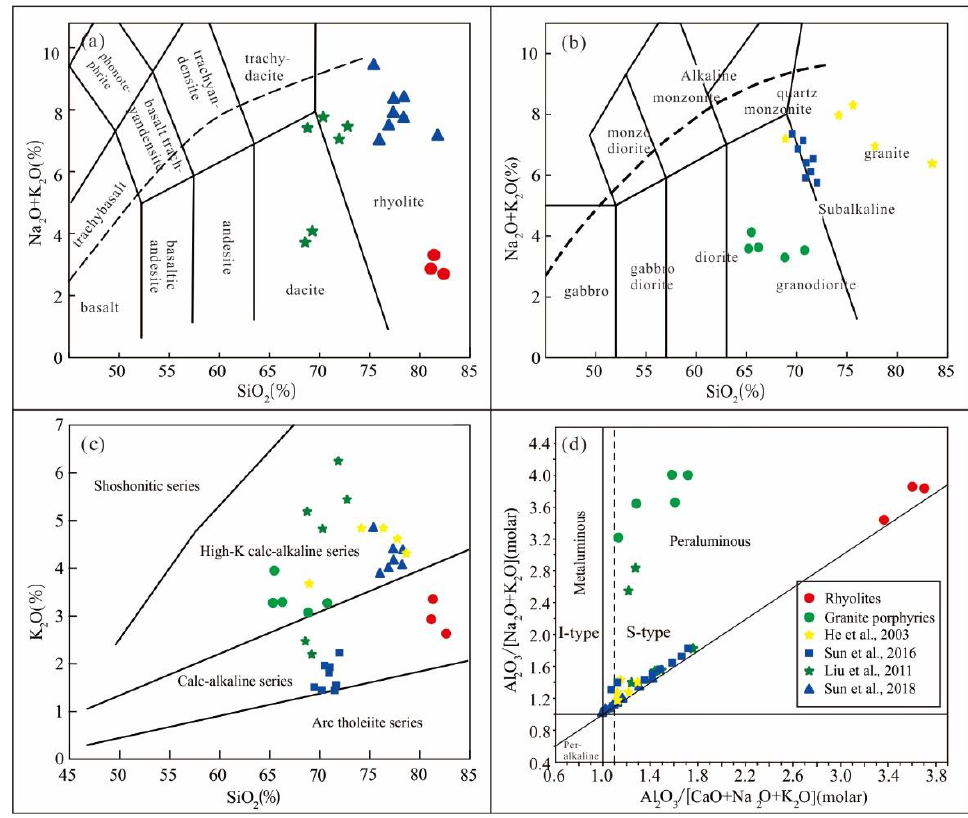
Figure 4. Classification and discriminant diagrams of magmatic rock. ( a ) SiO 2 vs. K 2 O + Na 2 O plot of volcanic rocks [56]; ( b ) SiO 2 vs. K 2 O + Na 2 O plot of intrusive rocks [56]; ( c ) K 2 O vs. SiO 2 plot [56]; ( d ) A/NK-A/CNK plot [57]. The samples of He et al. [30] are from the Zhenyuan gold deposits. The location and lithology of other samples from the references are shown in Figure 1.